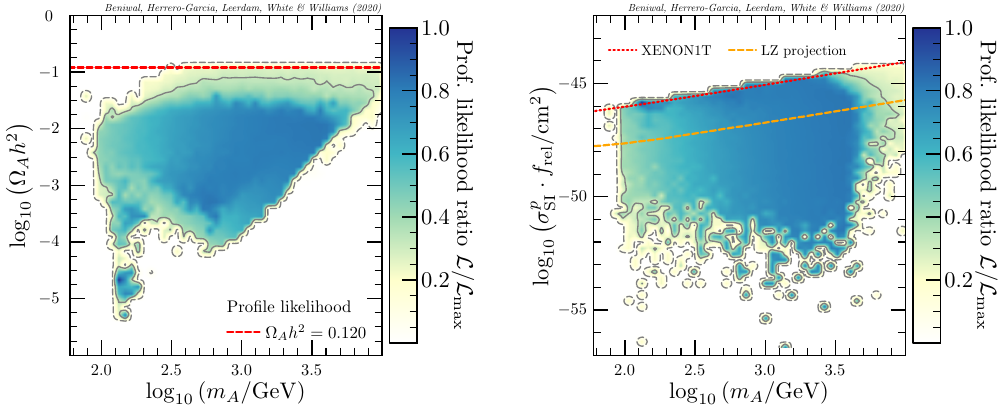
Figure 8 . Same as figure 2 but for the case of real pseudoscalar A